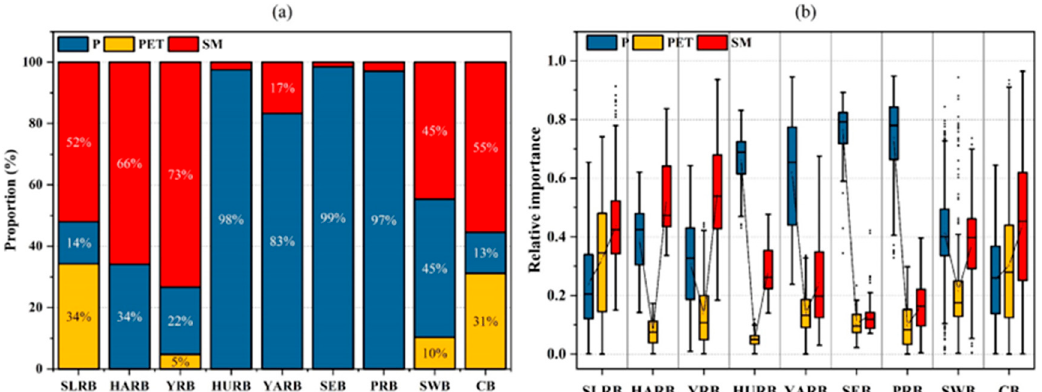
Figure 7. The proportion areas of primary drivers in the propagation from meteorological to hydro- logical drought across different river basins of China ( a ). The relative importance of drivers in drought propagation across different river basins of China ( b ). The drivers included P, PET, and SM.